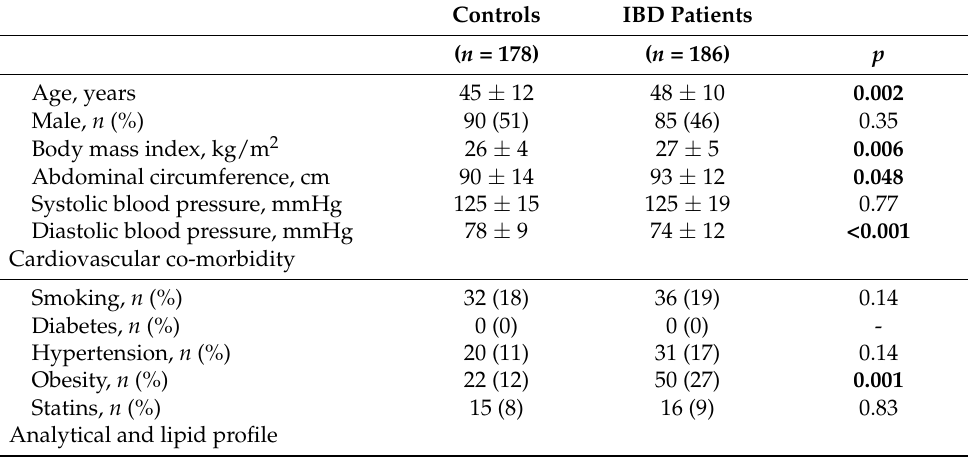
Table 1. Characteristics of patients with inflammatory bowel disease and